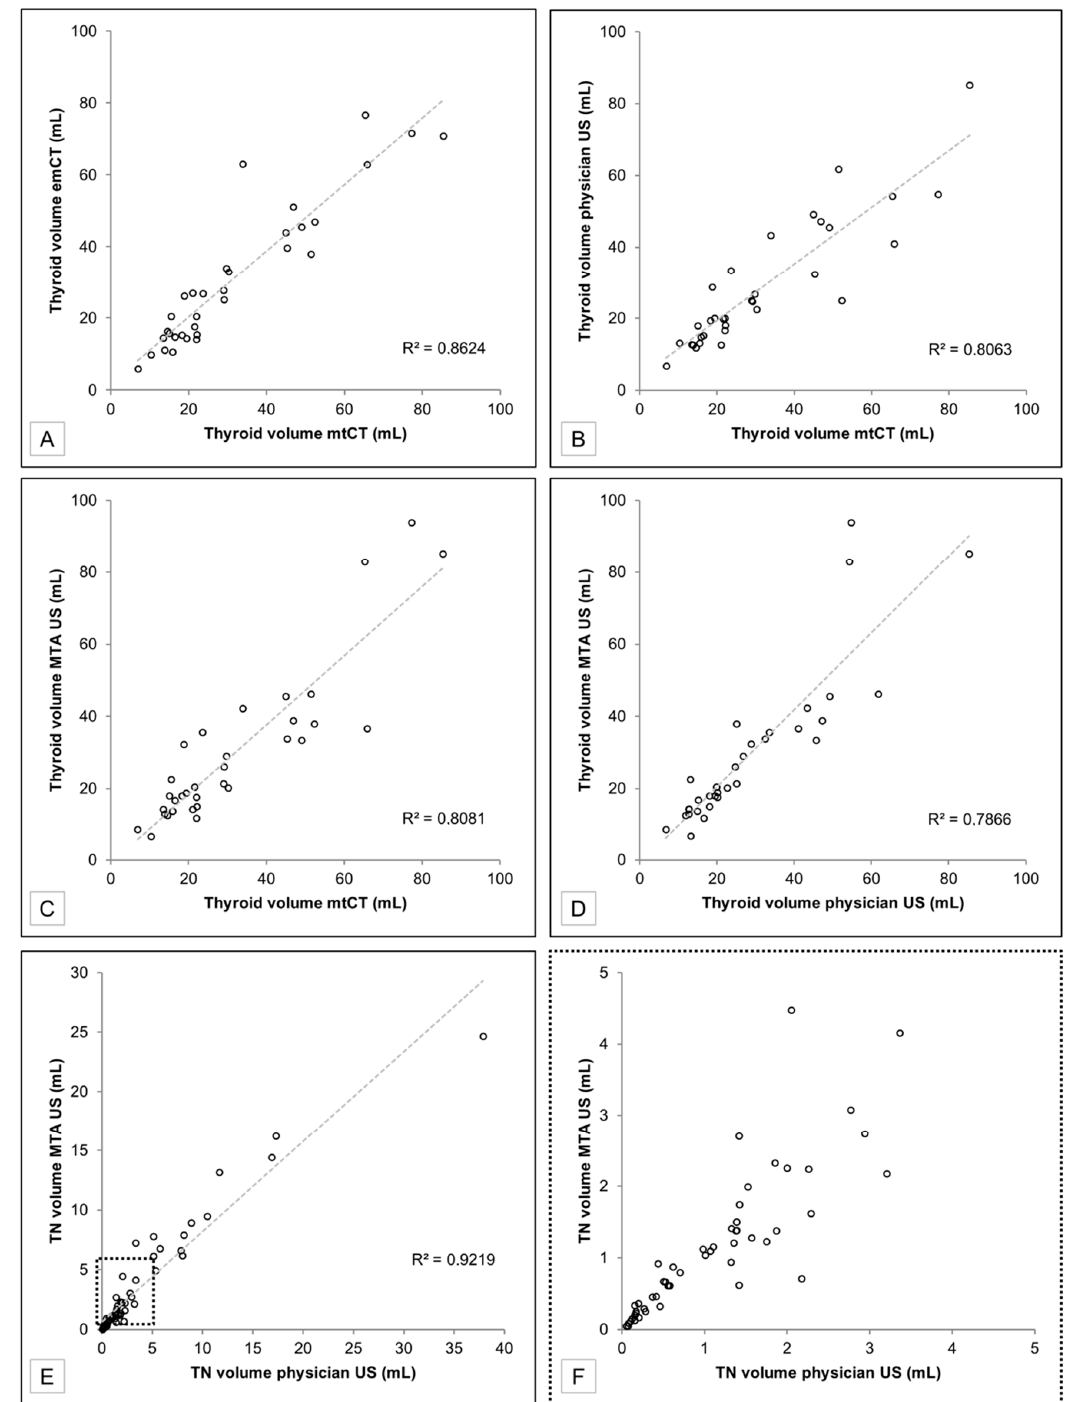
Figure 3. Correlation scatterplots of thyroid gland ( n = 33) and thyroid nodule ( n = 67) volume determinations. ( A )